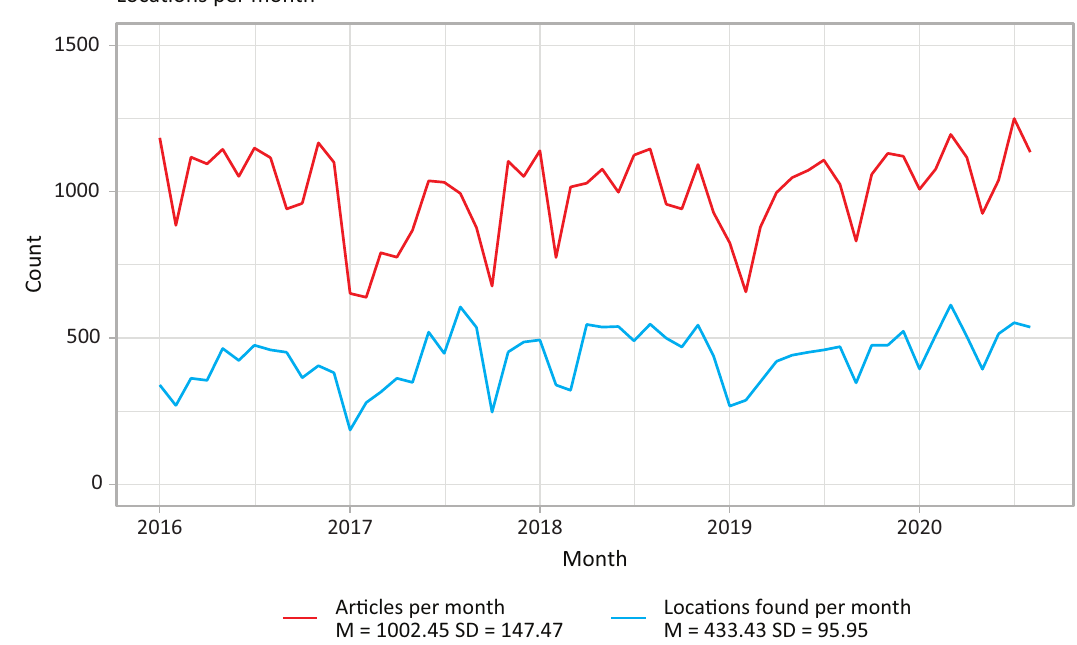
Figure 1. Total articles and recorded locations found per month from January 1, 2016, to August 31,